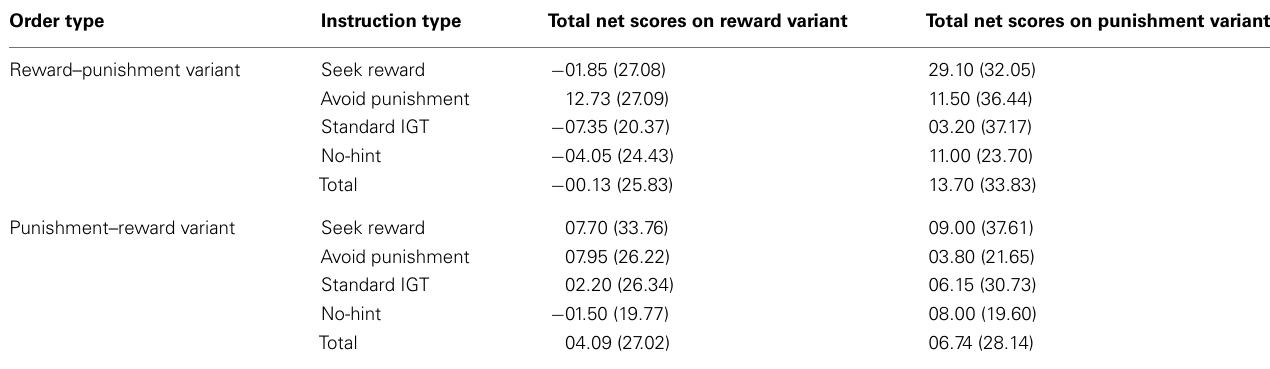
Table 1 | Mean and standard deviations of total net scores in the two variants by order ( n = 160; male = 80) and instruction types ( n = 40; male =